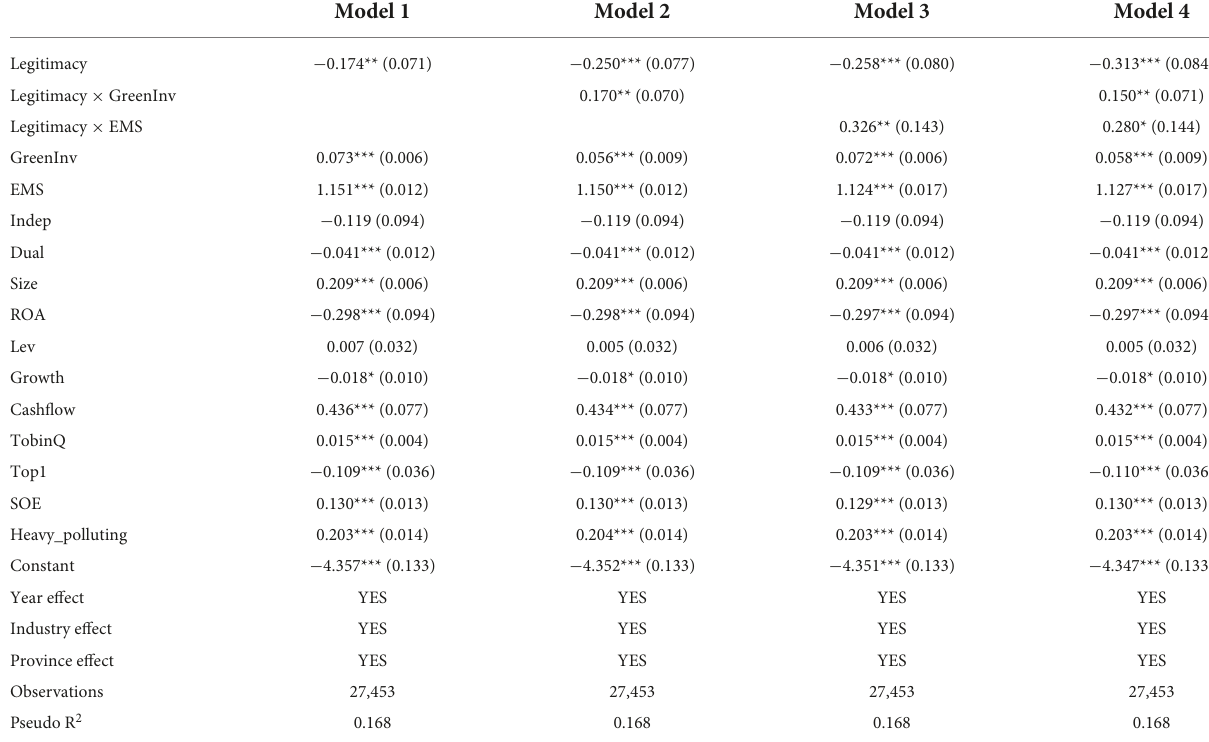
TABLE 8 Robustness check using Tobit